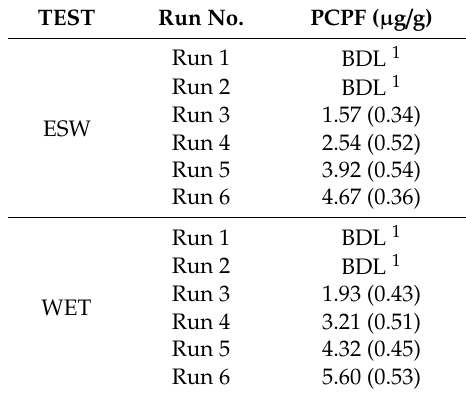
Table 8. Extracted Chlorpyrifos from PUFS–CPF by the Leaching Assay.